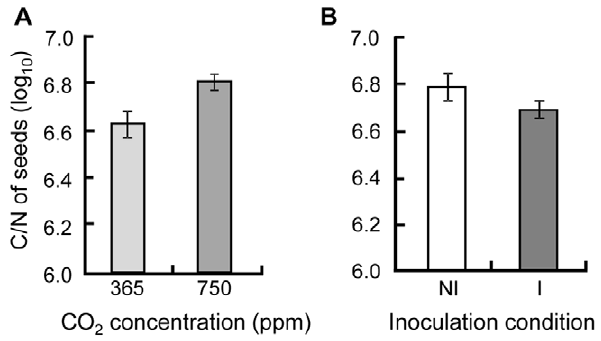
Figure 5. Carbon-Nitrogen ratio of Medicago truncatula seeds. Carbon-Nitrogen ratio of seeds depends on (A) the CO 2 concentration (ambient, 365 ppm or enriched, 750 ppm) and (B) the condition of inoculation (I: inoculated or NI: not with Pseudomonas fluorescens C7R12). Data were log-transformed to achieve normality and equal variances respectively tested by Shapiro-Wilk and Bartlett tests. Carbon- Nitrogen ratio, measured during the second experiment replicate only, was analysed by linear model with condition of inoculation, CO 2 concentration and developmental stage as fixed factors and with their interactions. Standard errors are represented by vertical bars.